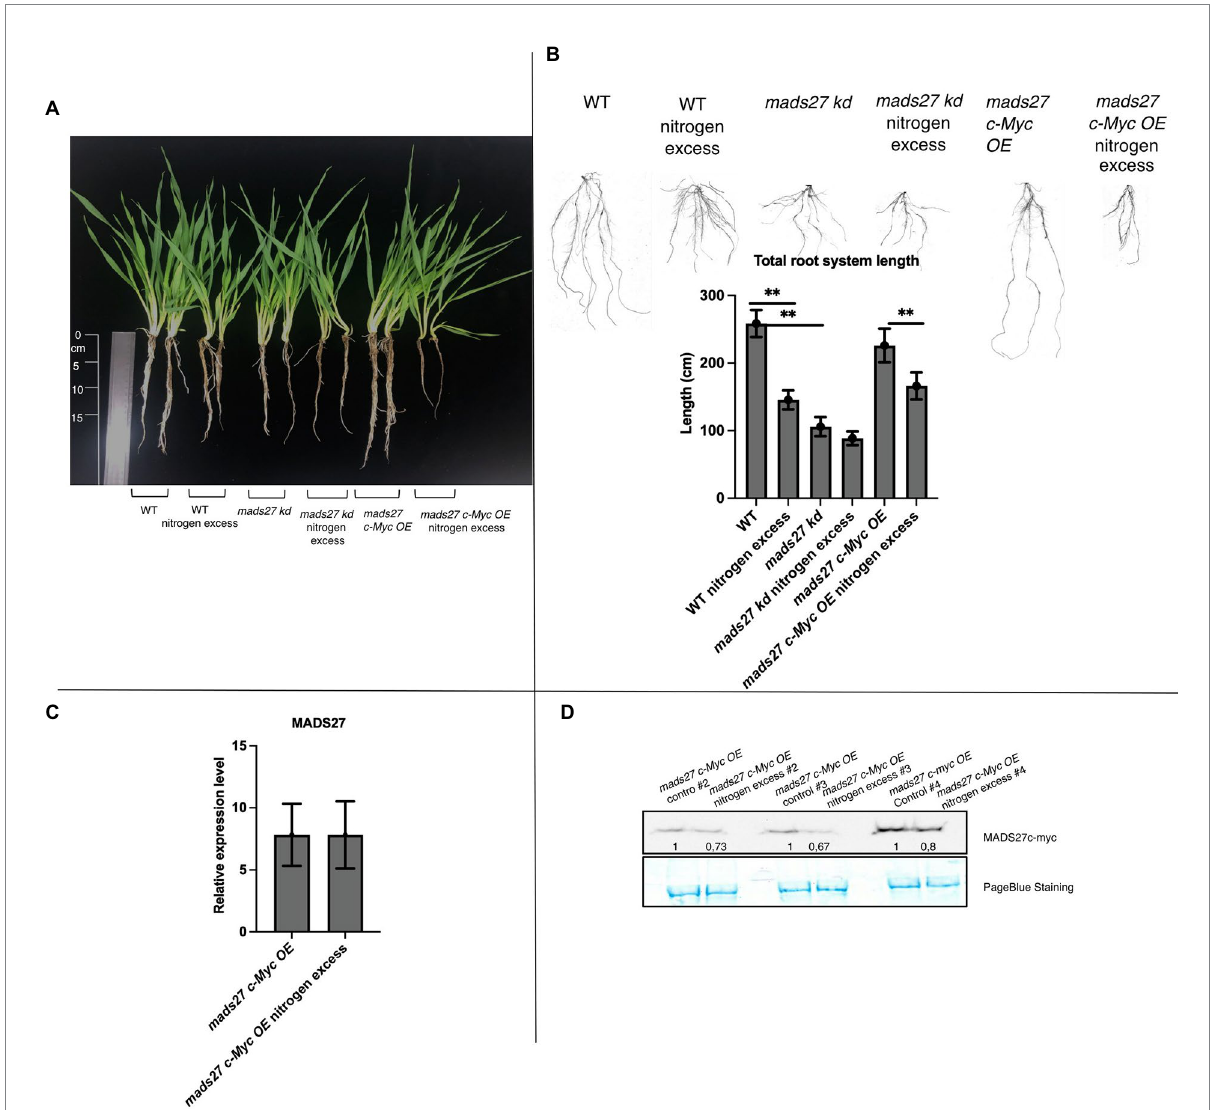
FIGURE 3 HvMADS27 regulates barley root architecture and excess N response. (A) WT and transgenic barley plants under control and excess N stress conditions. WT and mads27 c-Myc OE plants exhibited shorter roots under excess N condition compared with normal condition, whereas mads27 kd mutants exhibited shorter roots under control conditions, with no significant change under excess N stress. (B) Root length analysis using WinRHIZO software, with x -axis representing analyzed variants and y -axis representing total root length in cm. Scans of the root systems are provided. (C) RT-qPCR results depicting HvMADS27 mRNA relative to ARF 1 mRNA level (GenBank: AJ508228.2) expression in mads27 c-Myc OE mutant lines under control and excess N stress conditions. (D) Western blot analysis showed downregulation in HvMADS27 c-Myc protein level in mads27 c-Myc OE mutants under excess N treatment. PageBlue staining was used as loading control and numbers under MADS c-Myc signal depict results of densitometric analysis. Kruskal–Wallis test was performed to determine differences in root length; ** p <